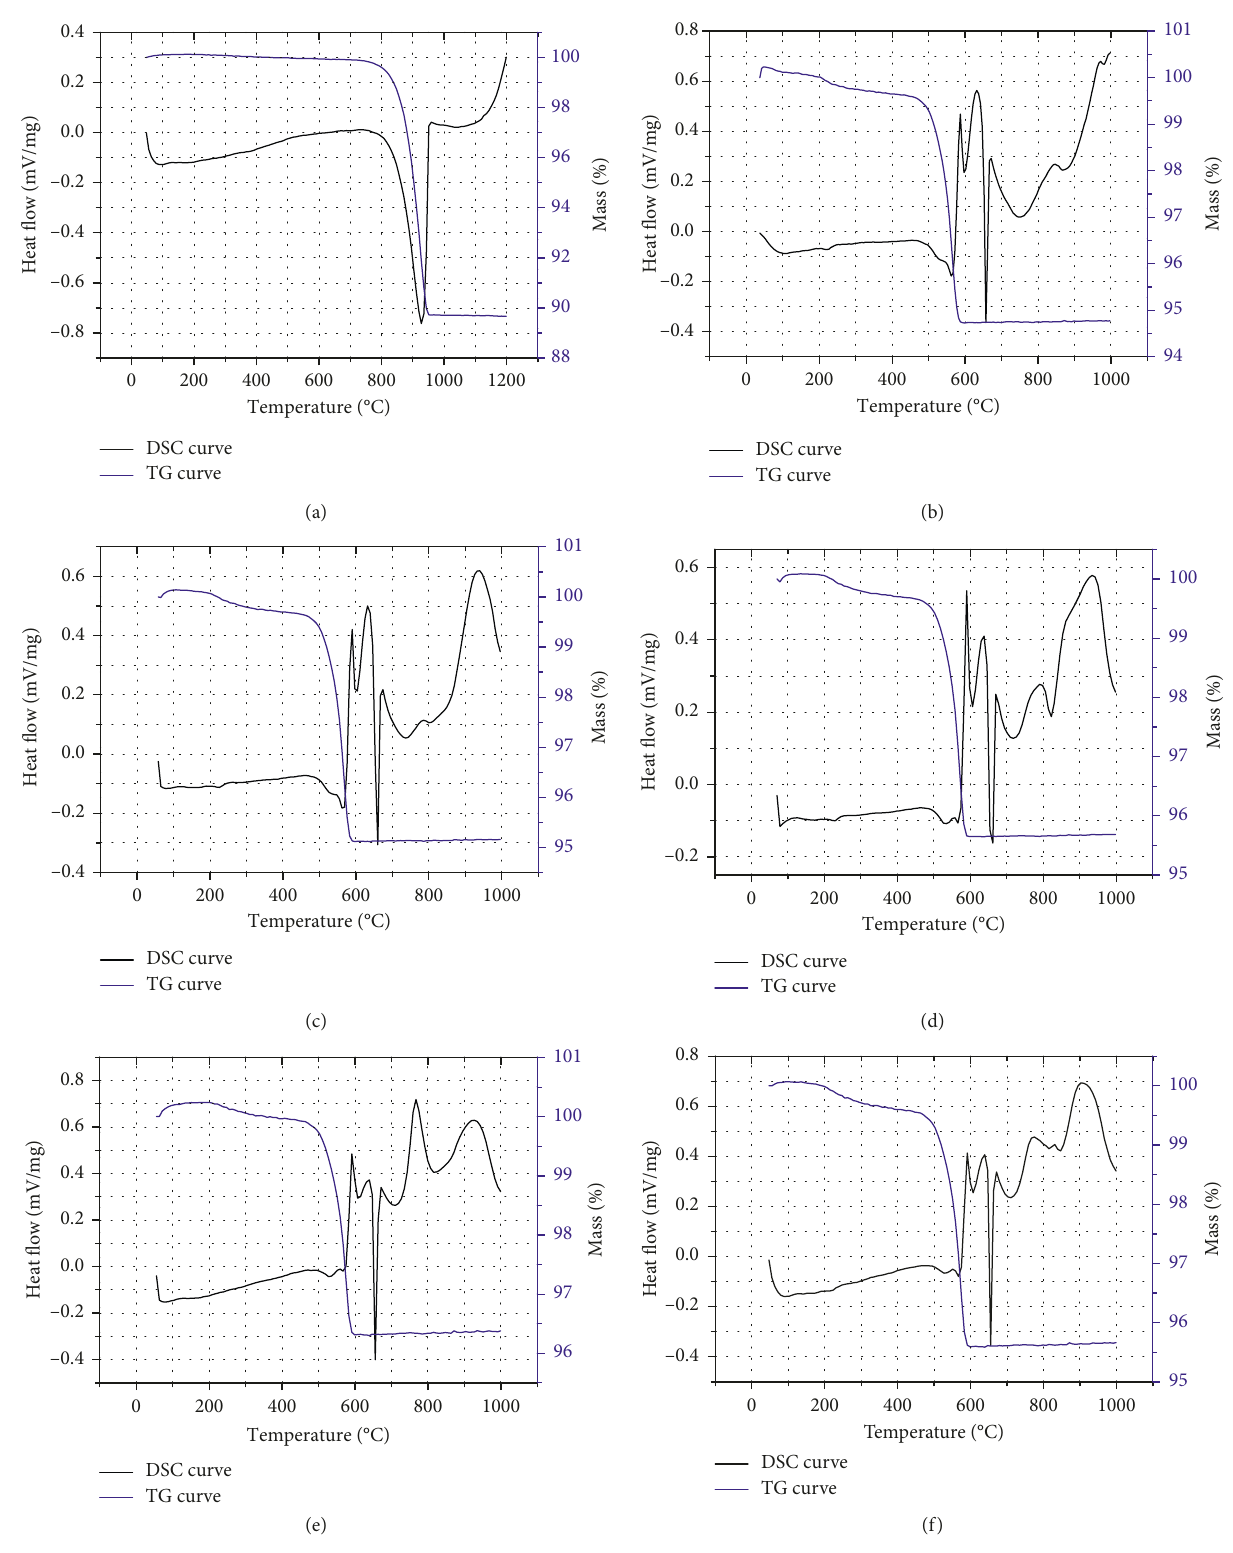
Figure 7: TG-DSC curves of different samples. (a) 0#. (b) 1#. (c) 2#. (d) 3#. (e) 4#. (f)